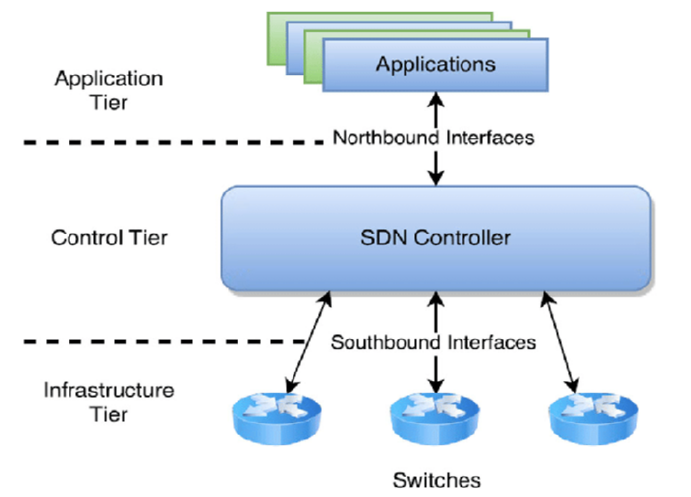
Figure 4. Logical View of Software-defined